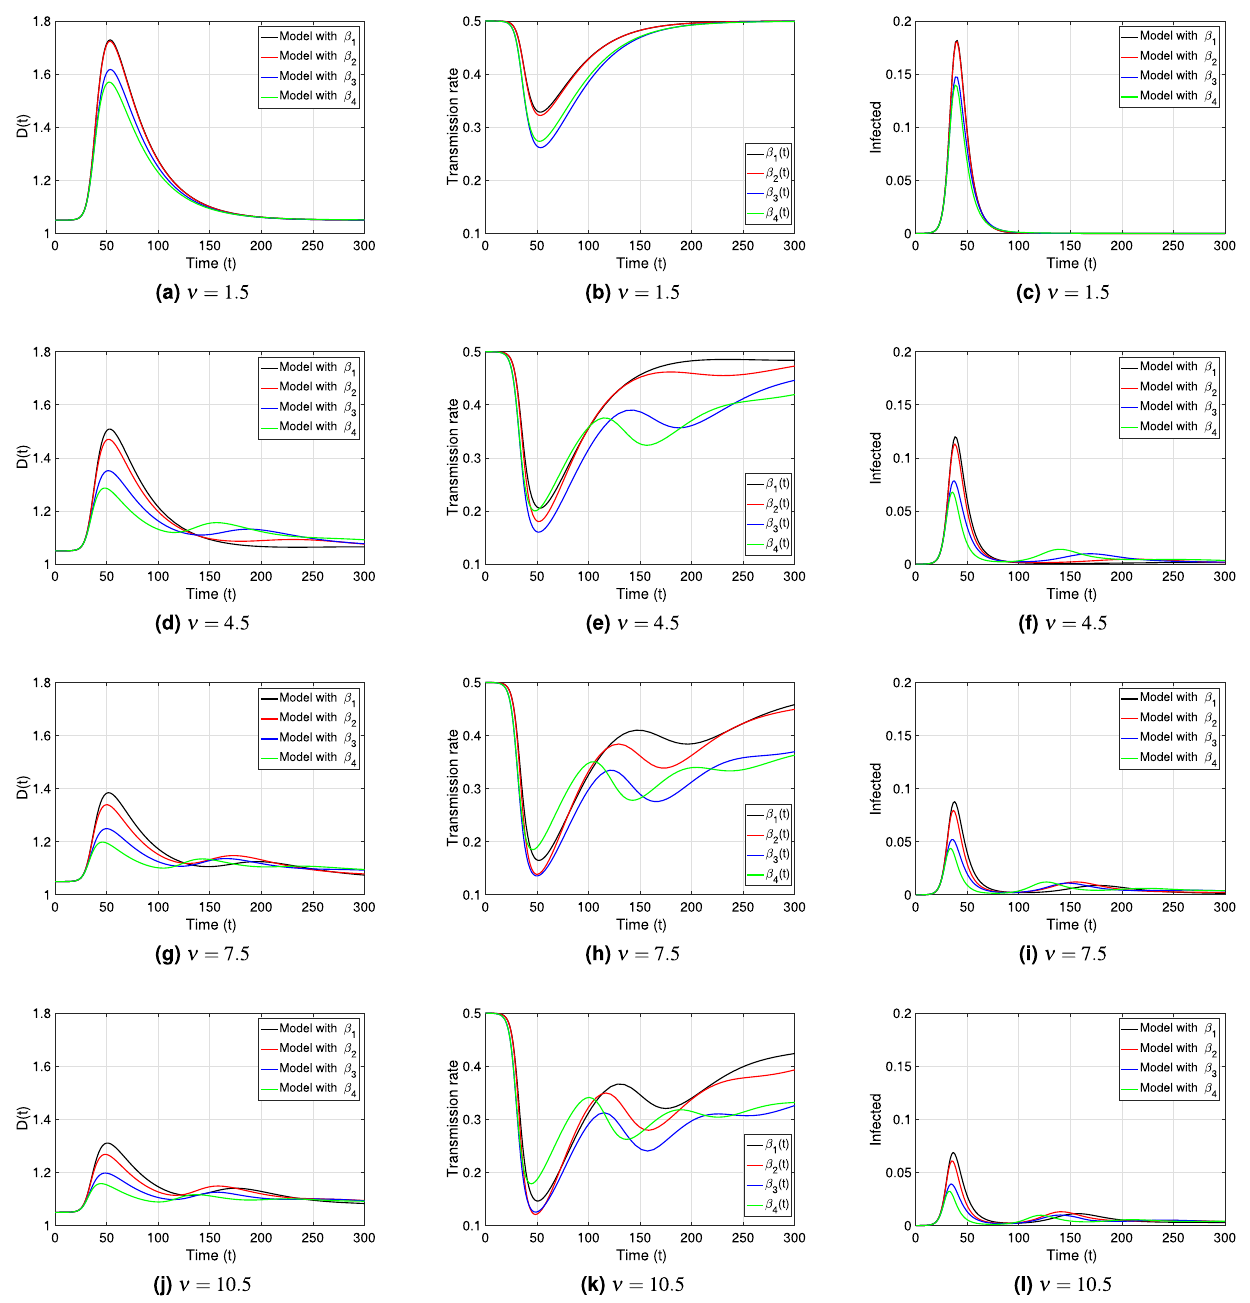
Figure 9. Temporal evolution of the interaction-distance D ( t ) (fist column); the transmission rates β i ( t ) = β i ( D ( t )) , i = 1, 2, 3, 4 , from Eqs. (6)–(9) (second column); and the point prevalence I ( t )/ N (third column); for ν = 1.5, 4.5, 7.5, 10.5 . The remaining parameter values were taken to be β ∗ = 0.5 ; γ = 0.2 ,